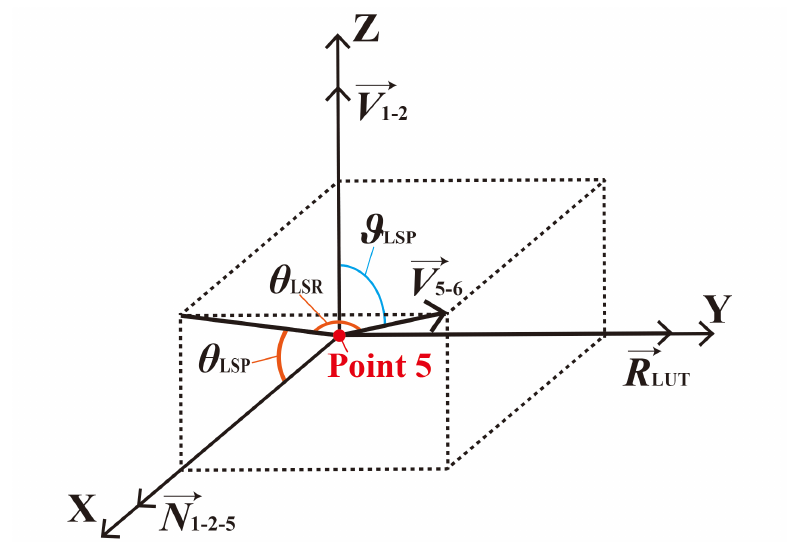
Figure 5. The link frame of the left upper torso of the human skeleton model and the shoulder joint angles for